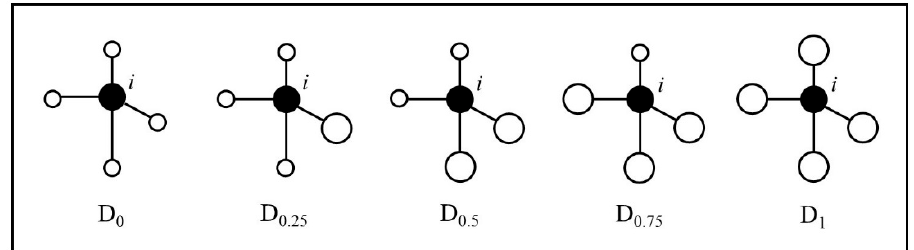
Figure 1. The case of a reference tree i (black) and its neighboring trees (white) in each competition level. The circle size is proportional to diameter at breast height (DBH).